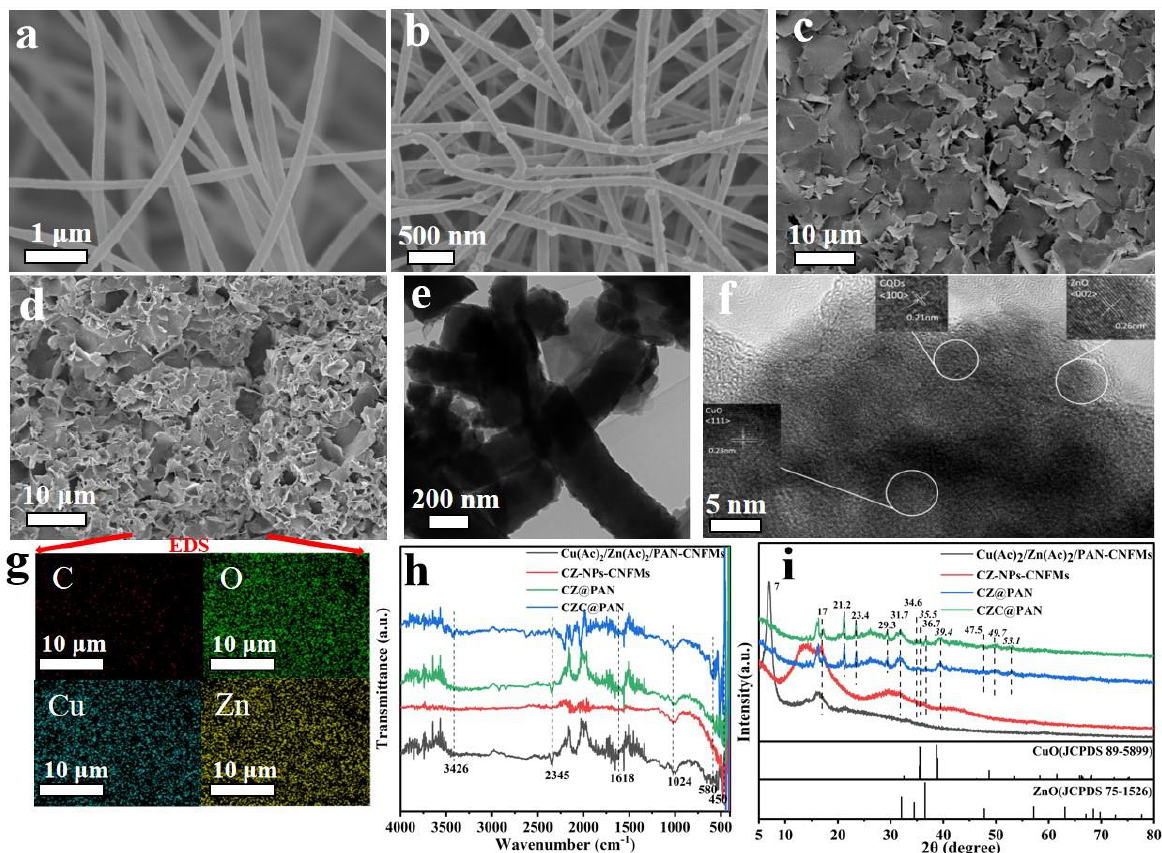
Figure 1. SEM image of Cu(Ac) 2 /Zn(Ac) 2 /PAN-CNFM ( a ); SEM image of CZ-NPs-CNFMs ( b ); SEM image of CZ@PAN ( c ); SEM image ( d ), HRTEM image ( e ), TEM image ( f ), and EDS results ( g ) of CZC@PAN; FTIR patterns ( h ) and XRD spectra ( i ) of samples.